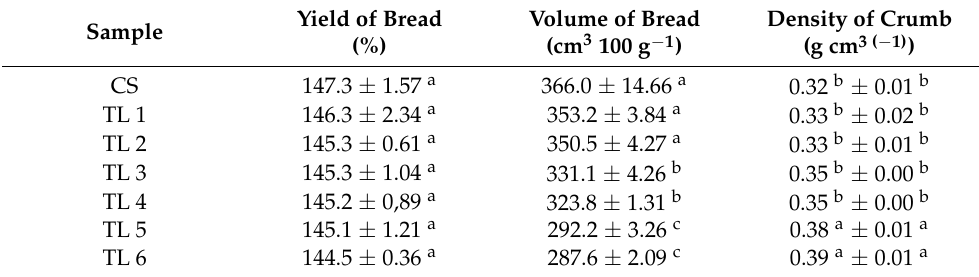
Table 2. Yield, volume, and density of bread crumb enriched with Taraxacum officinale .